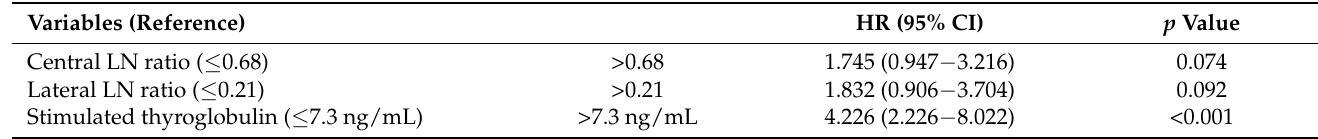
Table 5. Multivariate analysis related to